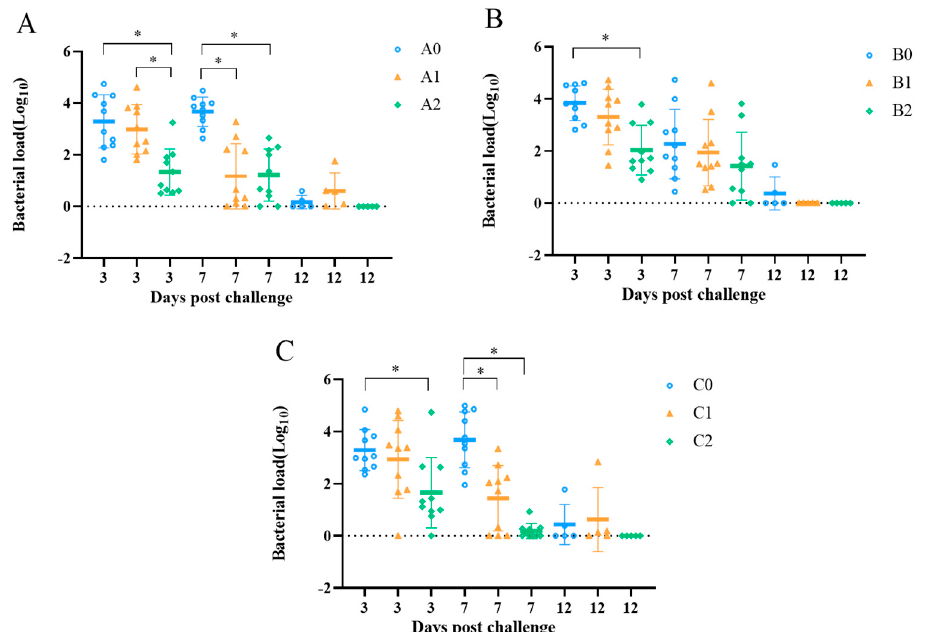
Figure 6. Bacterial shedding in chickens after challenge with Av. paragallinarum. The nasal swab samples were collected at 3, 7, and 12 days after challenge with 2019 − HB65 ( A ), 2019 − HB68 ( B ), and 2020 − JS80 ( C ) at 130 days old. * p < 0.05.